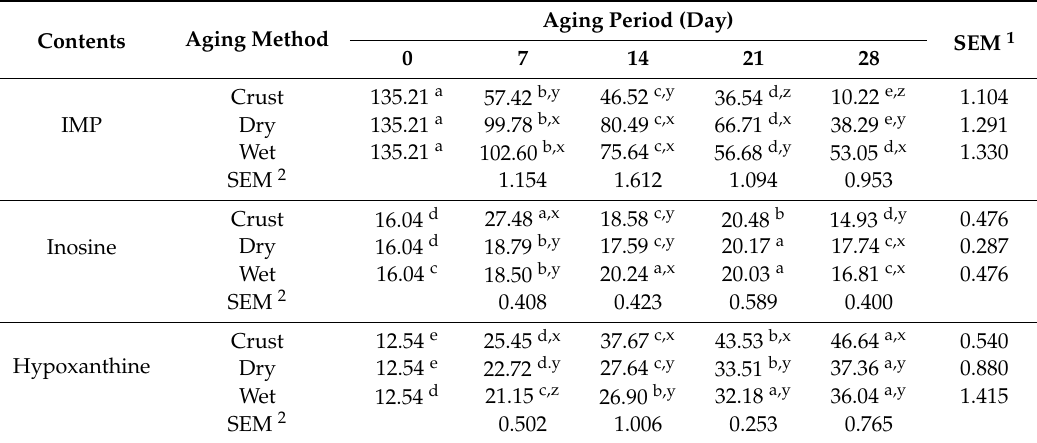
Table 3. Nucleotide contents (mg / 100 g) from di ff erent aged beef striploin ( longissimus lumborum )